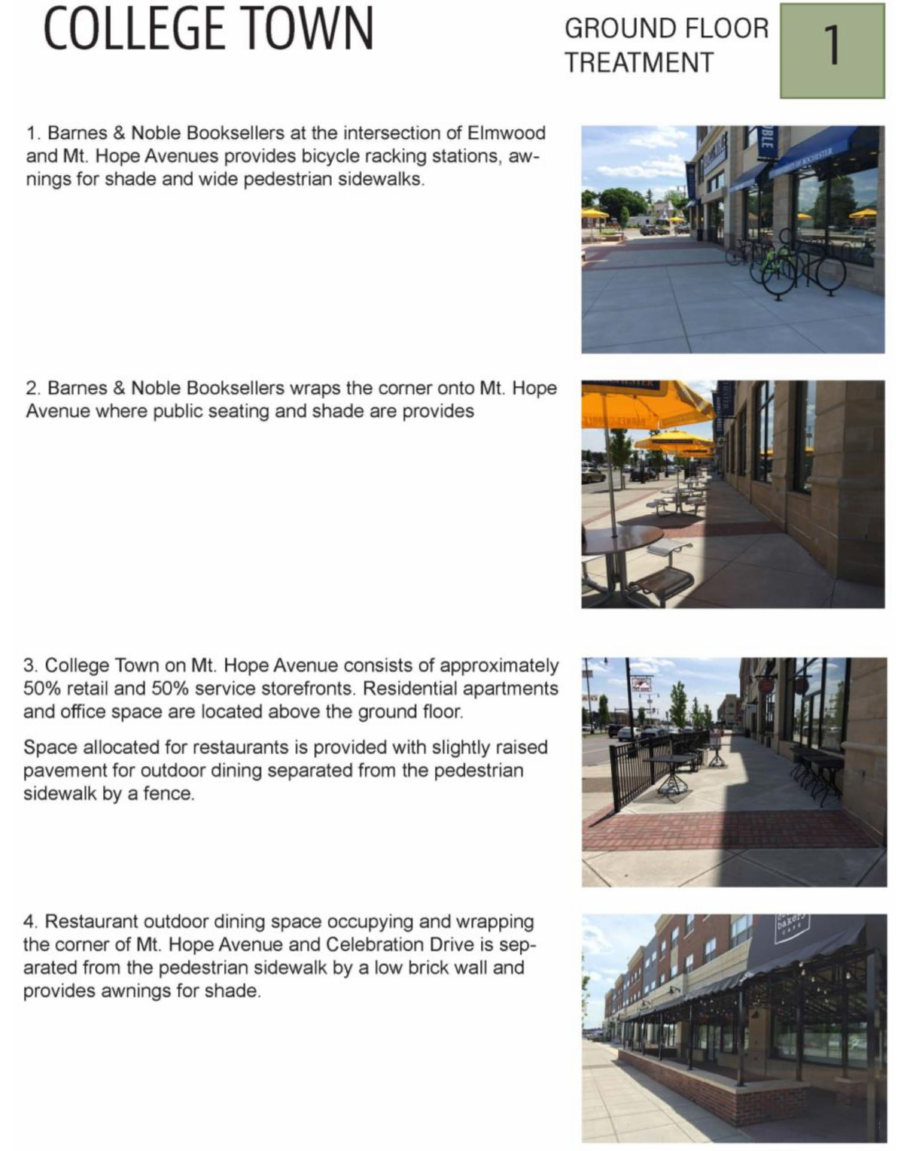
Figure 3. Sample Built Environment Profile Sheet (CT) (By